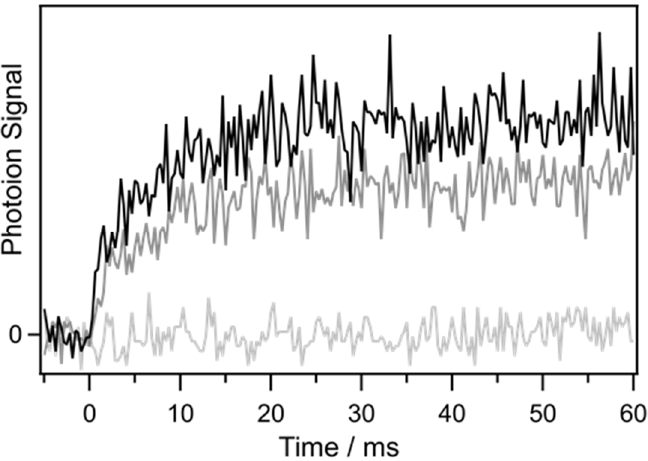
Figure 2. Temporal profile of m/z 99 observed from the reaction of MACR-oxide with formic acid (light grey line (formic acid) = 0 cm −3 , dark grey line (formic acid) = 6.6 × 10 12 cm −3 , black line (formic acid) = 5.7 × 10 13 cm −3 ) at a photoionization energy of 10.5 eV. The temporal profile reveals the rapid formation of a stable product that fragments upon ionization into a fragment ion at m/z 99. The small increase in the amplitude of the m/z 99 signal between the dark grey and black traces indicates the reaction is rapid and most of the MACR-oxide generated is reacted at (formic acid) = 6.6 × 10 12 cm −3 .